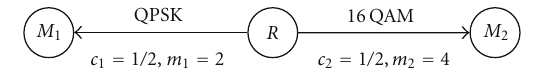
Figure 1: Two-way relay, a special case of the general model.